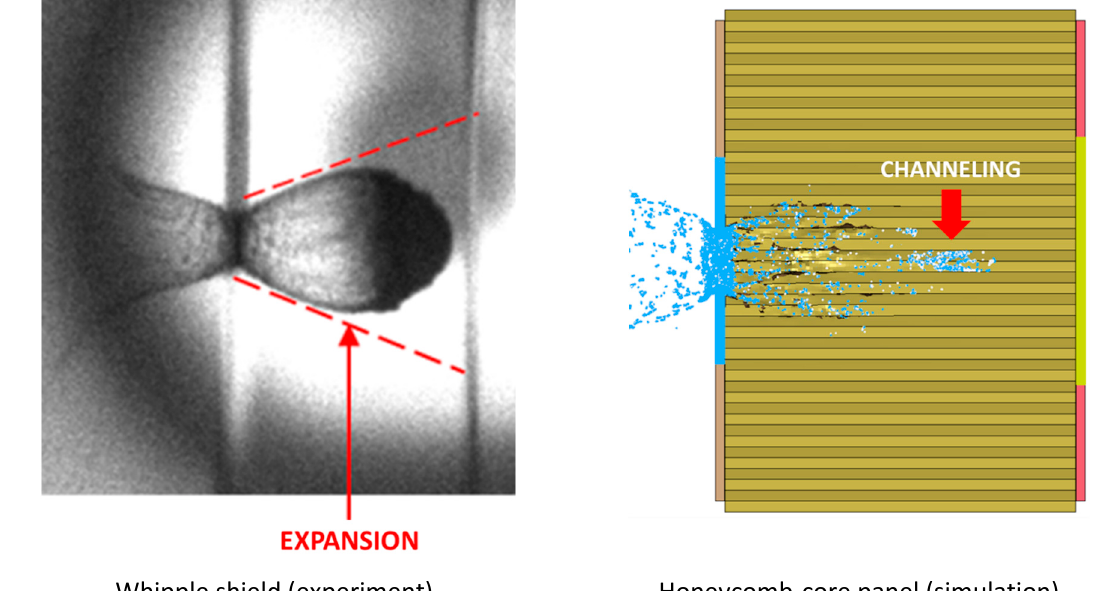
Whipple shield (experiment) Honeycomb‐core panel (simulation) Figure 2. Propagation of fragment cloud in between the front and rear walls of a Whipple shield ( left ) and a honeycomb-core sandwich panel ( right ) after 7 km/s sub-centimeter projectile impact. Effects of fragment cloud expansion and channeling are clearly visible.